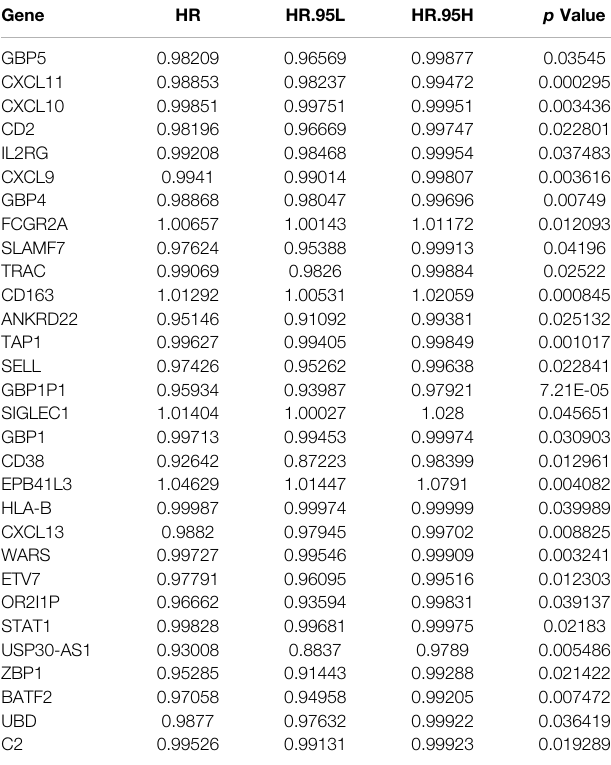
TABLE 2 | Prognosis-relevant characteristic immune subtype – derived genes in OC. Gene